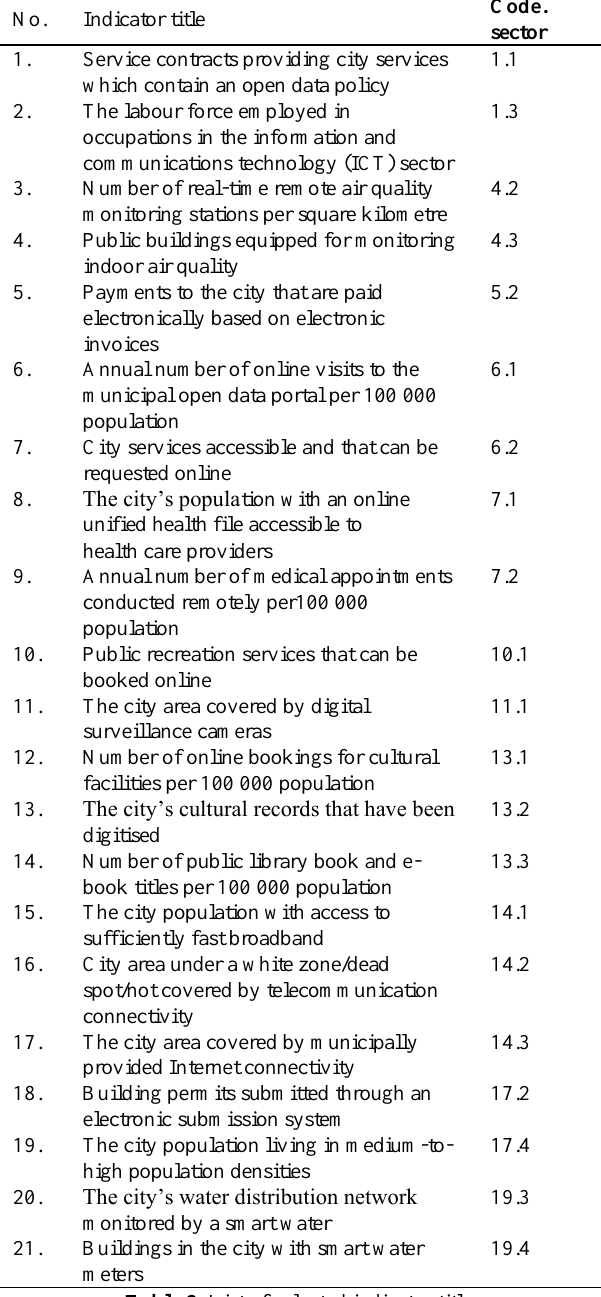
Table 2. List of selected indicator